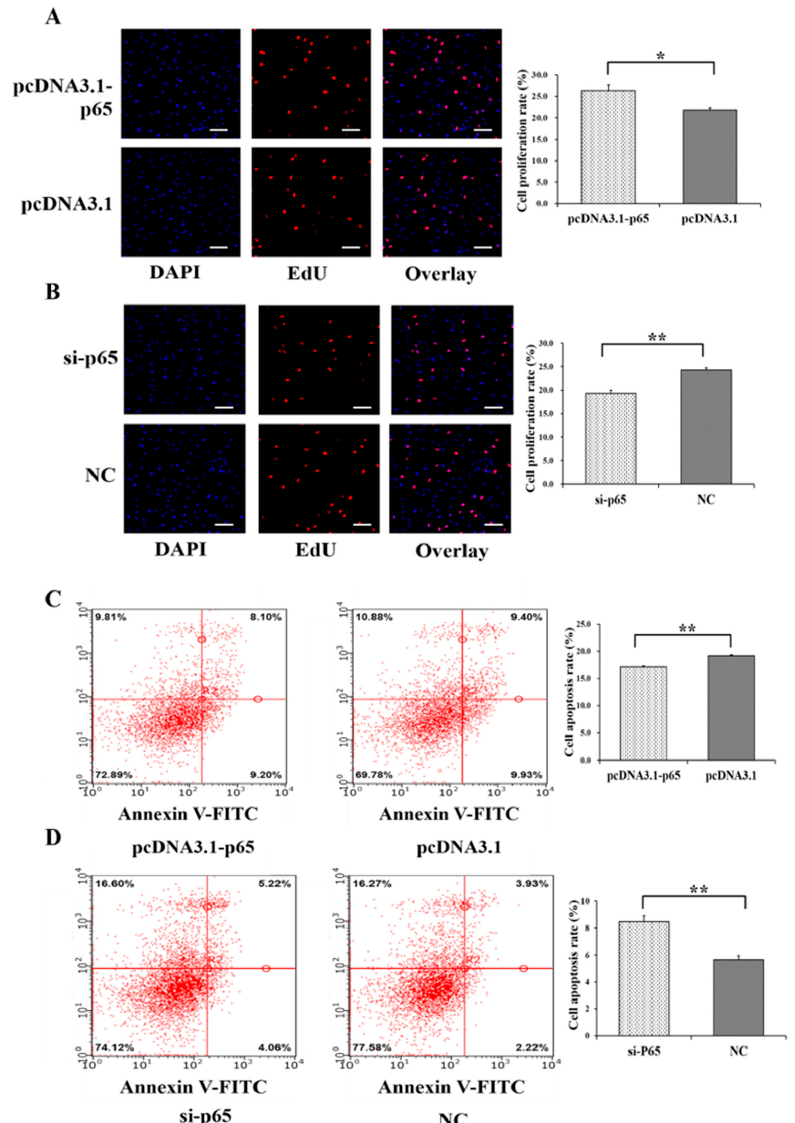
Figure 3. Biological effects of p65 on cell proliferation and apoptosis of GCs. The cell proliferation rate of GCs after treatment by pcDNA3.1-p65 ( A ) and si-p65 ( B ). The cell apoptosis rate of GCs after treatment by pcDNA3.1-p65 ( C ) and si-p65 ( D ). * indicates p < 0.05; ** indicates p < 0.01. Data are represented as means ± SD. The scale bar represents 100 µ m. NC: negative control. PcDNA3.1-p65: pcDNA3.1 overexpression plasmid of p65 ; si-p65: specific siRNA for p65 .